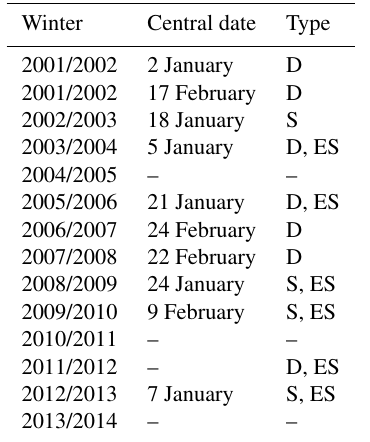
Table 1. Central dates of major SSWs in the time period 2001/2002–2013/2014. Vortex displacement events are indicated by “D”, and vortex split events by “S”. Events with an elevated stratopause forming after the SSW are additionally marked by